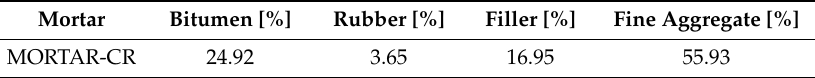
Table 3. Mortar percentage composition.